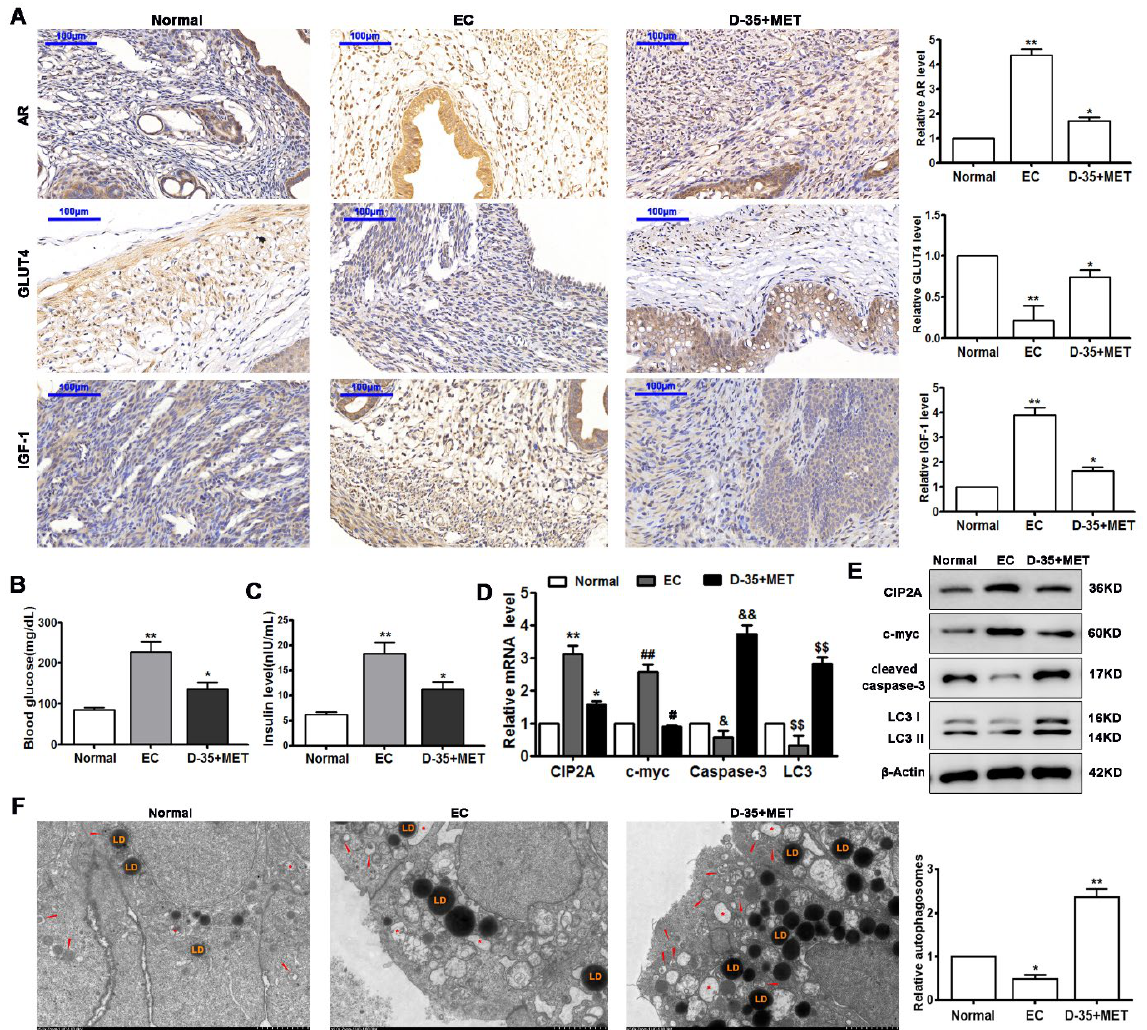
Figure 7. Diane-35 and metformin administration ameliorated EC in vivo. An orthotopic xenograft model was established in nude mice. Endometrium tissues of the model in mice were obtained for the immunohistochemistry analysis ( A ), scale bars = 100 μm. Insulin resistance was assessed by using the blood glucose level ( B )and blood insulin level ( C ). CIP2A, c-myc, cleaved caspase-3, and LC3 I/II mRNA ( D ) and protein ( E ) expression. Transmission electron microscope analysis of patients’ tissues. Autophagosomes: red arrow, autolysosome: white arrow, lysosome: red asterisk, and lipid droplet: LD, scale bars = 2 μm ( F ). Data are shown as the mean ± S.D. * p < 0.05, # p < 0.05, & p < 0.05 and ** p < 0.01, ## p < 0.01, && p < 0.01, ANOVA.